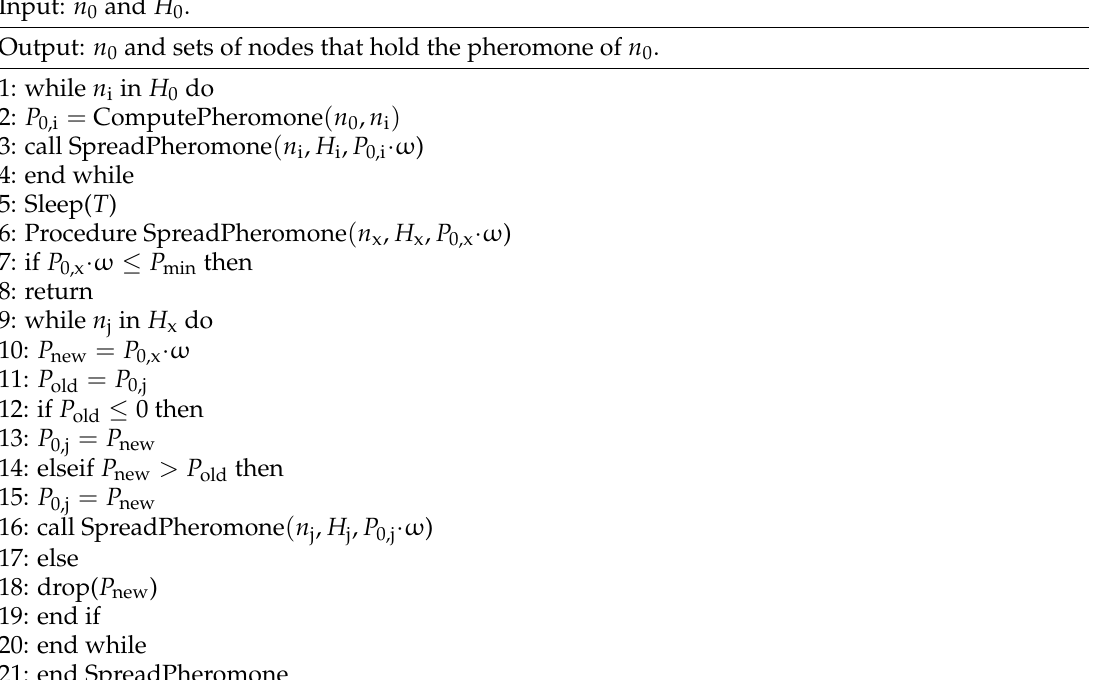
Algorithm 1. Community construction algorithm of n 0